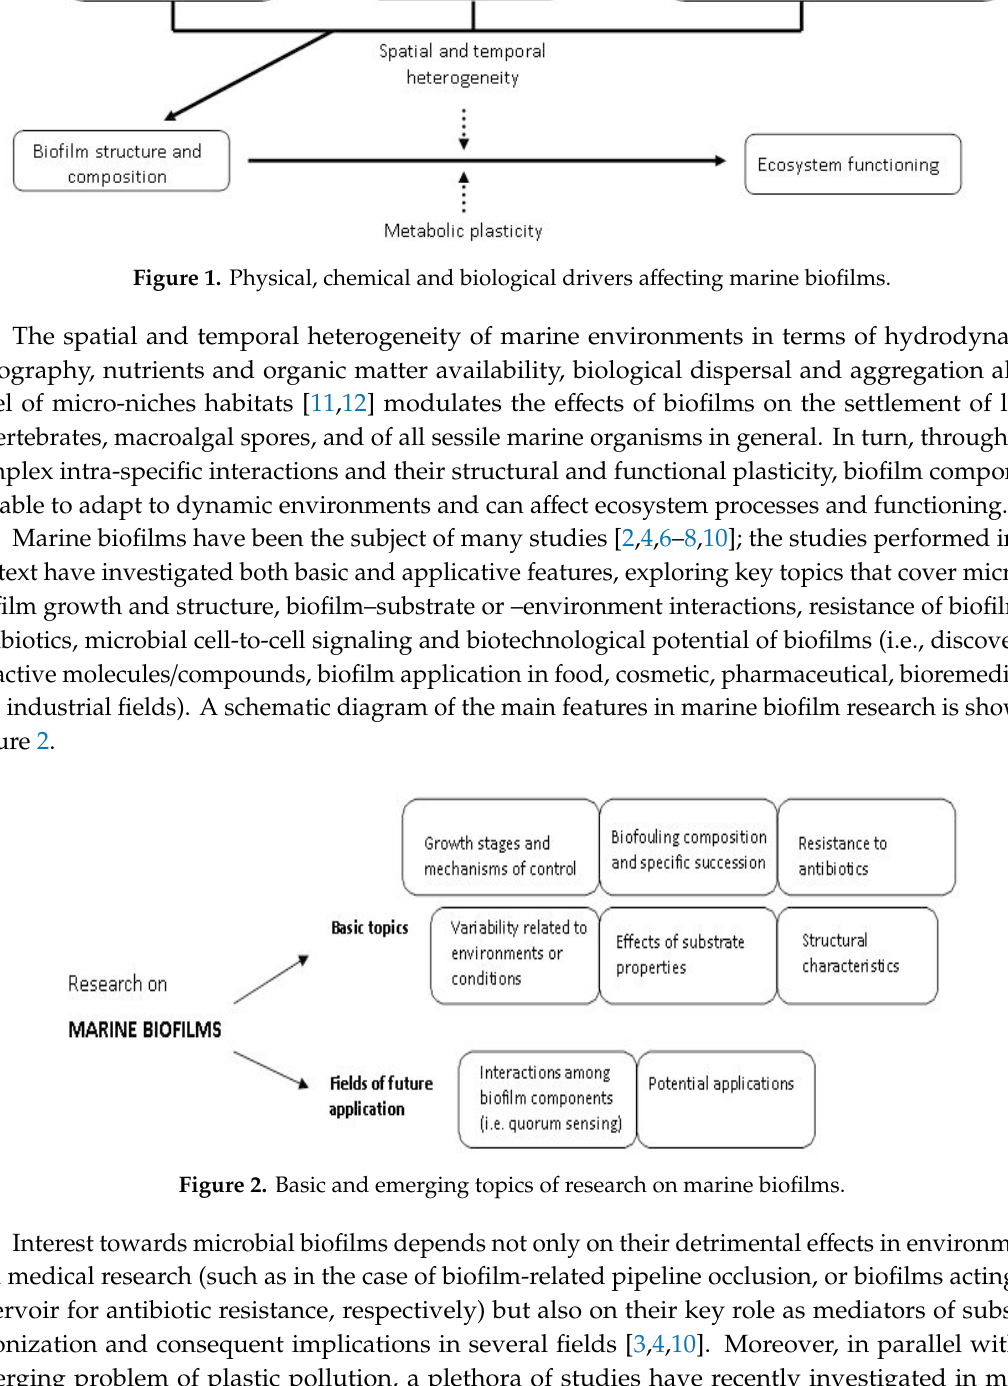
Figure 2. Basic and emerging topics of research on marine biofilms.